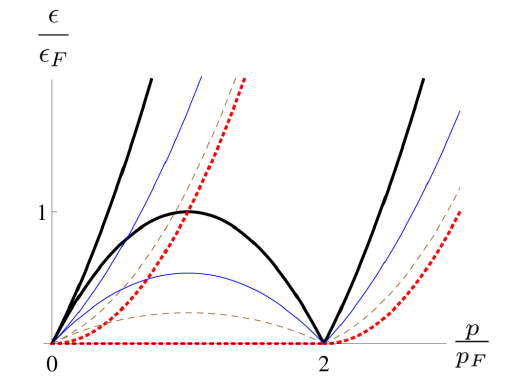
Figure 9: Type I and type II spectra for several values of the interaction strength, from the non- interacting Bose gas (red, dashed) [ 122 ] to the Tonks-Girardeau regime (black, solid, thick) with intermediate values α = 0.6 (brown, dashed) and α = 2 (blue,